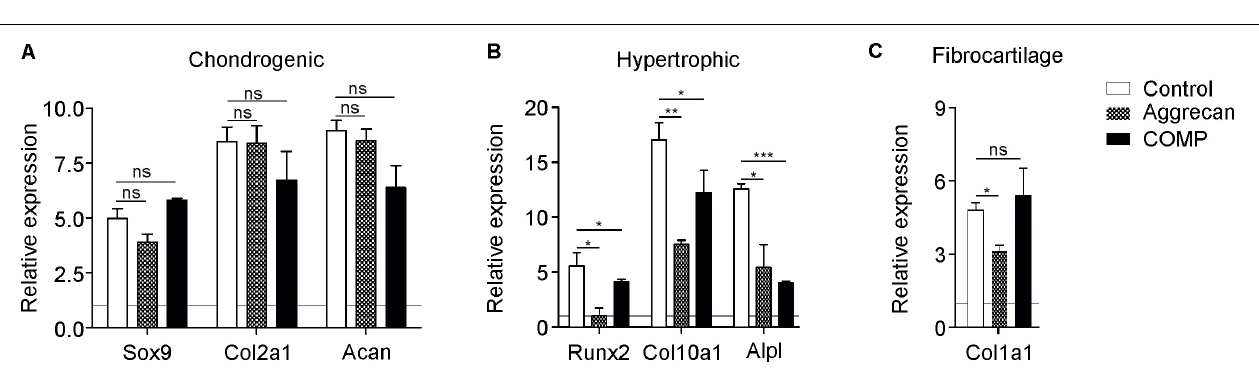
FIGURE 1 | Addition of Aggrecan or COMP during chondrogenic differentiation of rabbit periosteal cells results in decreased hypertrophic differentiation. Periosteal derived cells differentiated in chondrogenic lineage under control conditions (white bars) and with Aggrecan (2 µ g/ml; dotted bars) or COMP (200 µ g/ml; black bars) for 21 days. (A) Induction of chondrogenic markers Sox9, Col2a1, and Acan mRNA expression was determined by RT-qPCR, normalized for 28S rRNA expression and set relative to baseline ( t = 0) values (indicated by horizontal line). (B) Induction of hypertrophic markers Runx2, Col10a1, and Alpl mRNA expression was determined similarly to samples from (A) . (C) ALP enzyme activity in cell lysates of same conditions was determined and normalized to total protein content. (D) Fibrocartilage marker Col1a1 mRNA expression as determined in similarly to from (A) . In graphs, error bars represent mean ± SEM. Statistically significant differences ( p < 0.05) are shown by an *, ** = p < 0.01, ns = not significant.